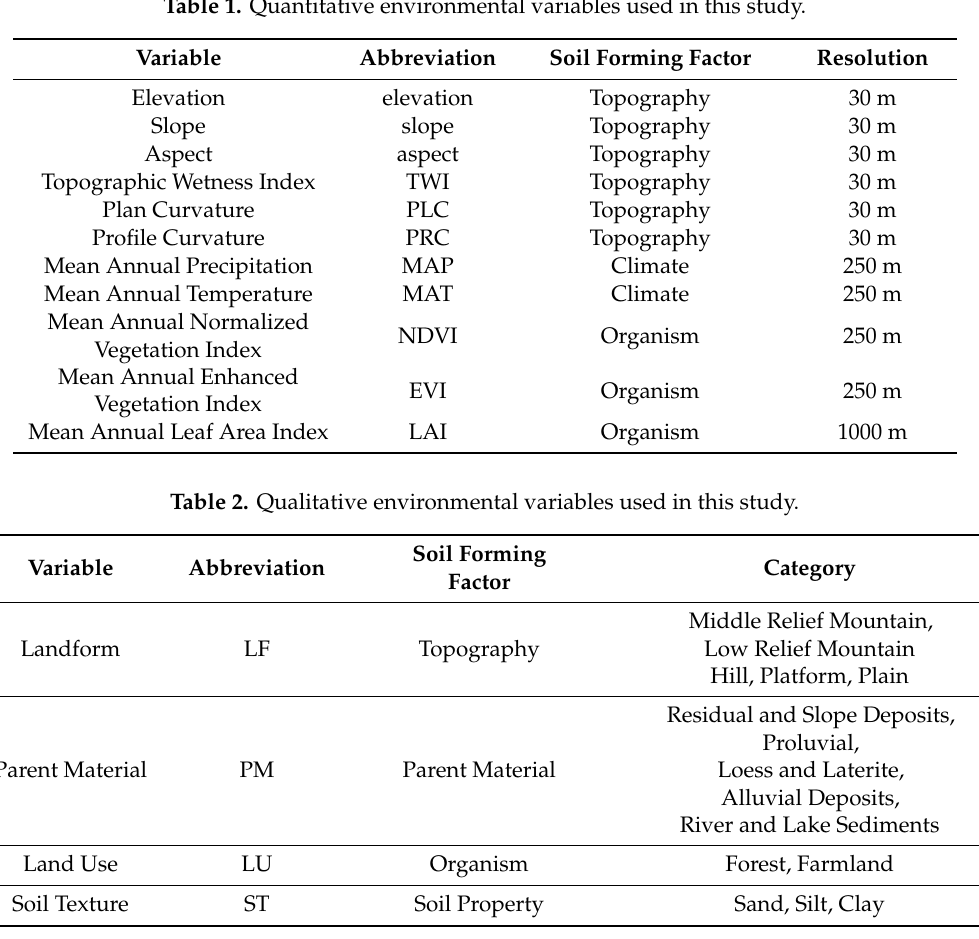
Table 1. Quantitative environmental variables used in this study.